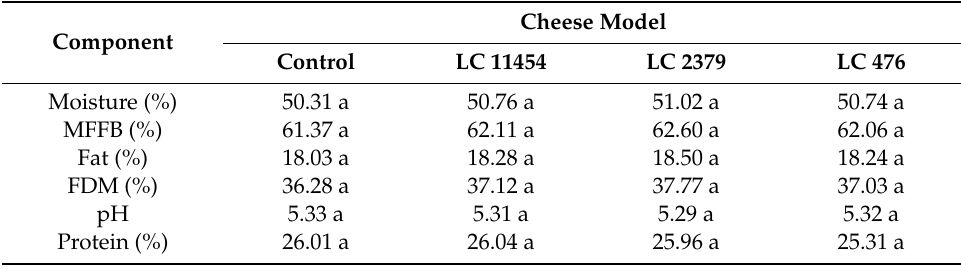
Table 3. Chemical composition of cheese models after 5 weeks of ripening.